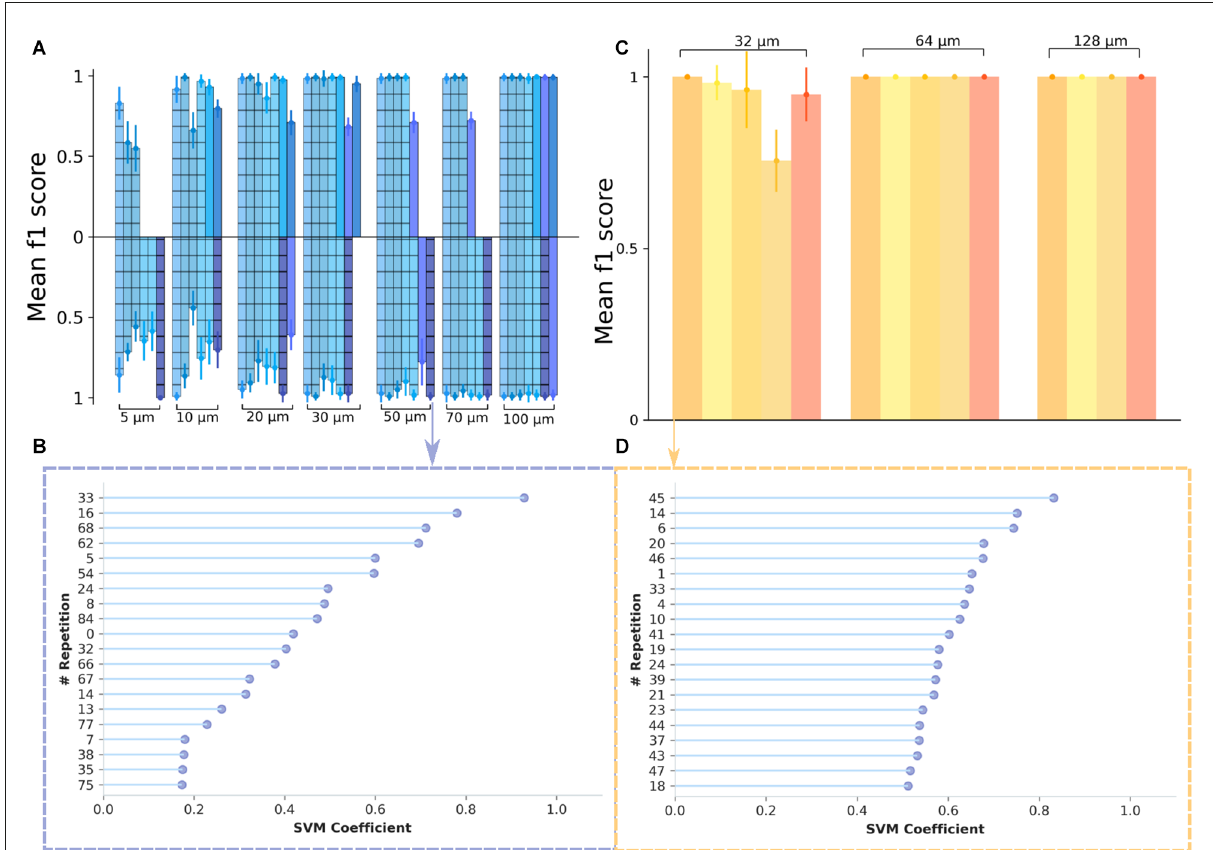
FIGURE4 Inferring the spatial resolution of optogenetically and electrically stimulated RGCs from a support vector machines classifier. (A) Classification results are shown as f 1 score values for data obtained from optogenetic experiments. The different colors denote different experimental days. On the upper side of the plot are data from the 2.5 Hz switching frequency and on the lower side are data from the 10 Hz switching frequency. A classifier’s performance is considered to be significant when the f 1 score is above the “chance level” which, in this case, we considered to be at 0.5. With the exception of one recording day, the metrics show a notably high value for all of the spatial frequencies considered, reaching saturation at around 30 µ m for 2.5 Hz and 50 µ m for 10 Hz. (C) Classification results for data obtained from electrical stimulation experiments. The different colors correspond to different experimental days. The saturation is reached at 64 µ m for all datasets considered. However, for some experimental days, we note particularly high values for the 32 µ m grating width as well. (B,D) Feature importance plot showing the most significant 20 features (vectors containing firing rate values for individual stimulus repetitions) for the classifier. In panel (B) there is an exemplary plot for good classification results, for the case of the 50 µ m grating width, with a 10 Hz pattern reversal from an optogenetic stimulation dataset, while in panel (D) the plot shows an example of the feature importance for the 32 µ m grating width, in the case of an electrical stimulation